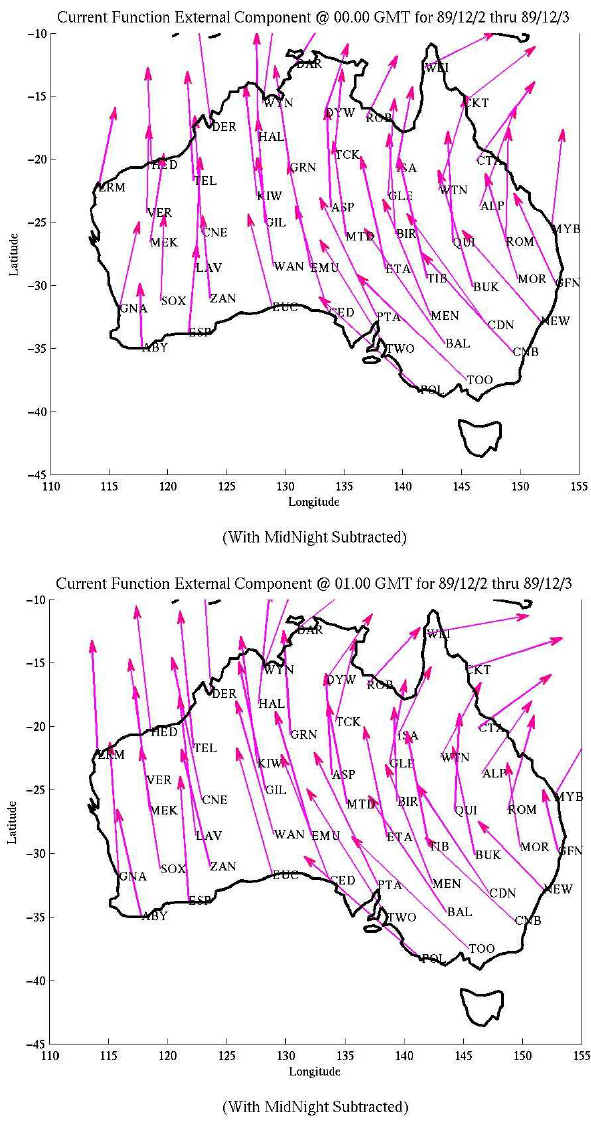
Fig. 4. As for Fig. 1 but for 00:00 and 01:00 UT on 3 December 1989. Arrow lengths: 5 ◦ longitude length is equivalent to 22nT.